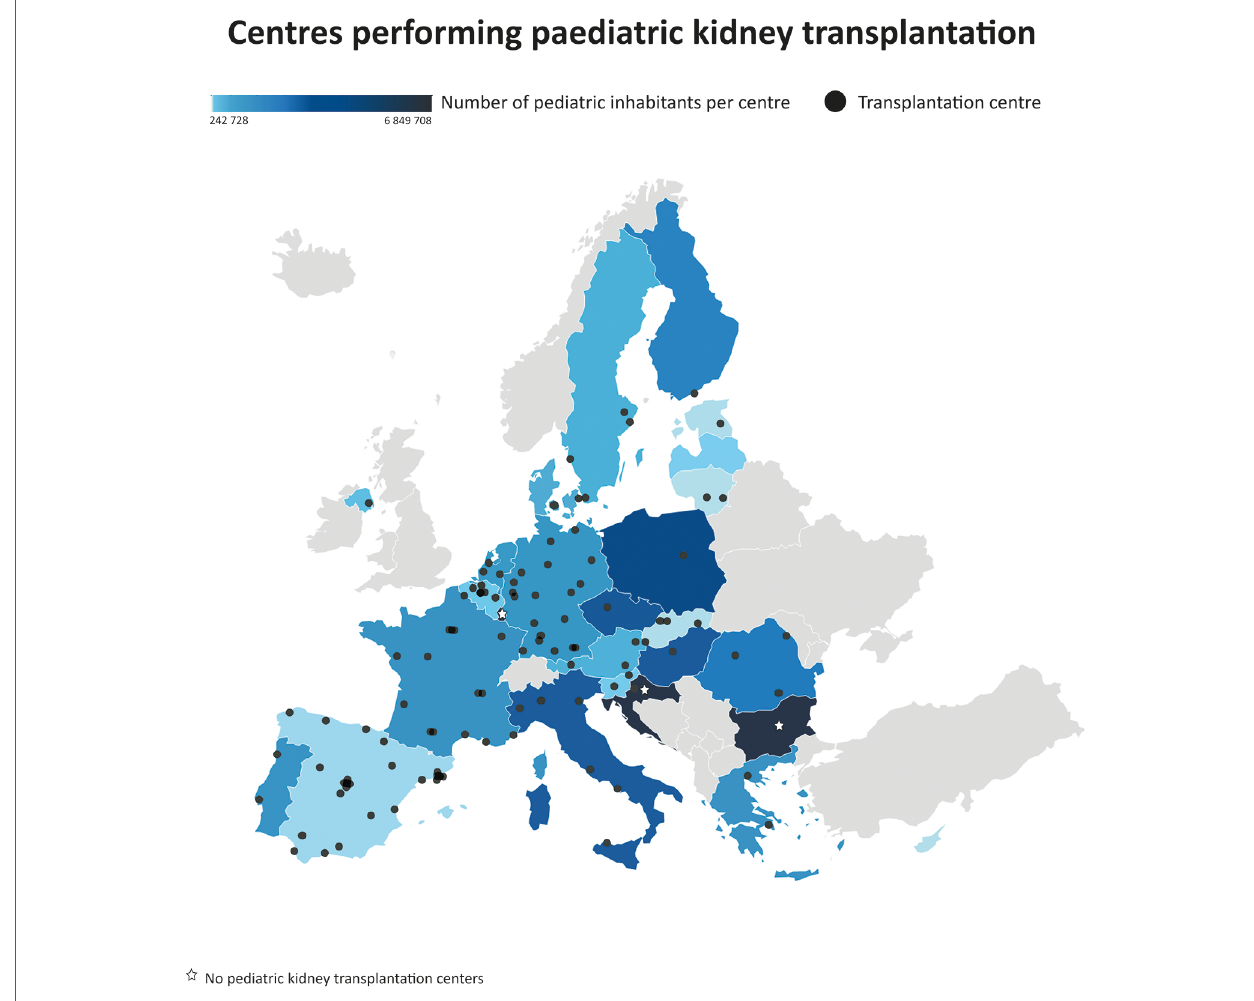
FIGURE 1 Choropleth of Europe depicting country-wise heat distribution based on the paediatric population per kidney transplantation centre. Centres ( N =109) that performed paediatric kidney transplantation surgery in 27 European countries. Both certi fi ed and non-certi fi ed centres are